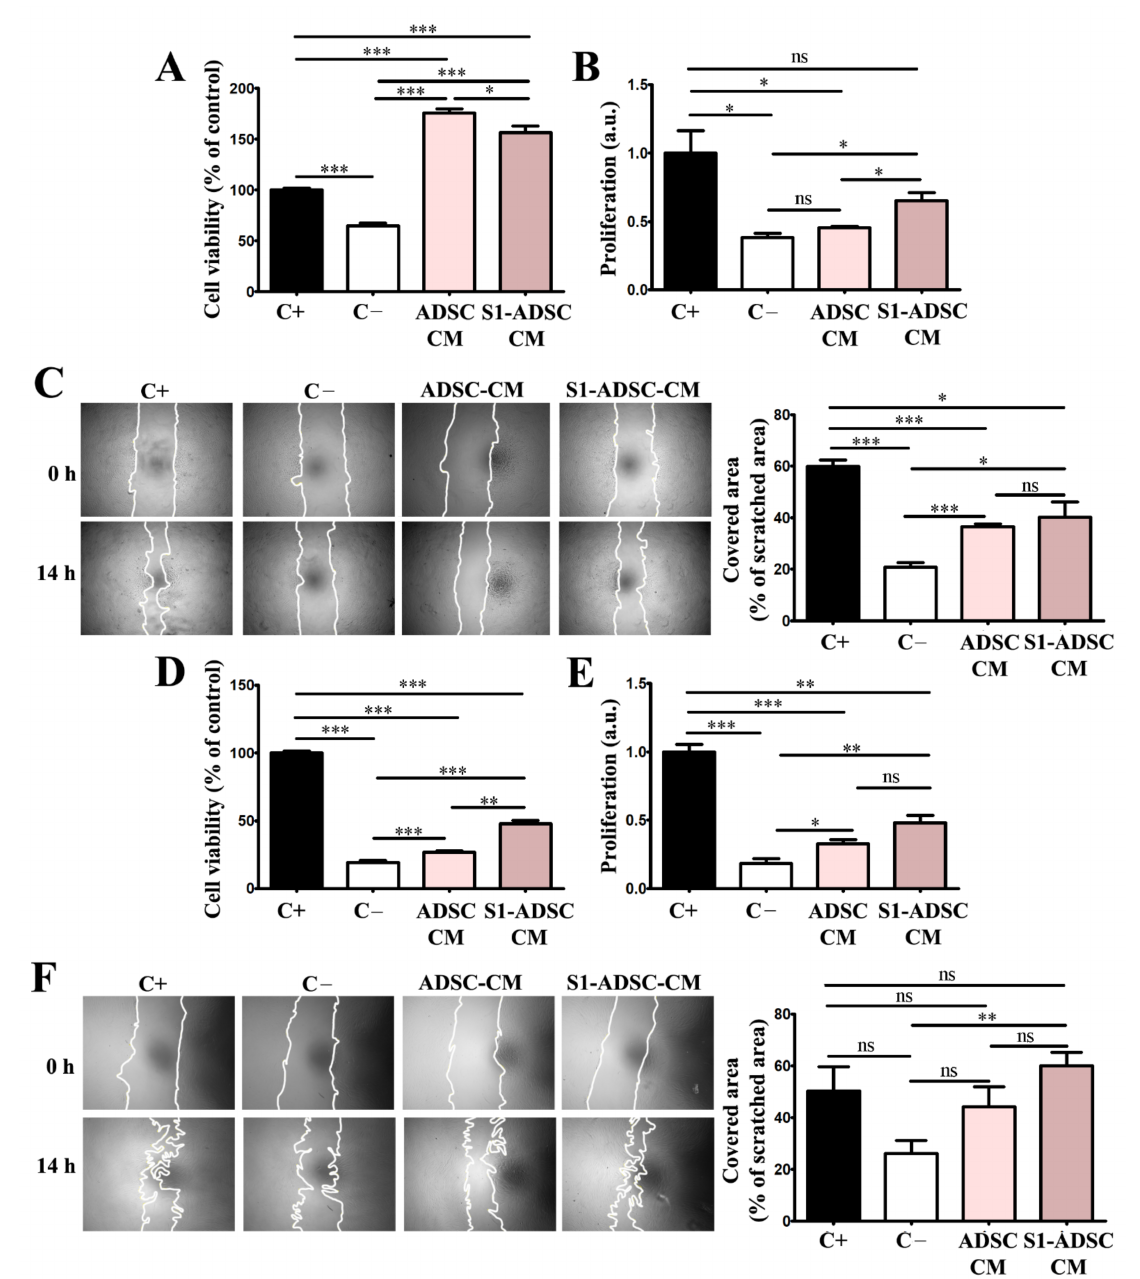
Figure 5. Assessment of the cell viability, proliferation and migration induced by hTERT S1-ADSC- CM on keratinocytes and hDF. ( A ) XTT assay showing the viability of keratinocytes cultured for 5 days in the presence of hTERT S1-ADSC-CM versus ADSC-CM; ( B ) Assessment of the capacity of hTERT S1-ADSC-CM versus ADSC-CM to promote keratinocyte proliferation as revealed by DNA quantification; ( C ) Keratinocyte migration assessed by Scratch test: (left) phase-contrast microscopy showing the scratched area at t = 0 h and 14 h later and (right) the quantification of covered area as a percentage of the initial scratched area. ( D ) XTT assay showing the viability of fibroblasts cultured for 5 days in the presence of hTERT S1-ADSC-CM versus ADSC-CM; ( E ) Assessment of the capacity of hTERT S1-ADSC-CM versus ADSC-CM to promote fibroblast proliferation as shown by DNA quantification; ( F ) Fibroblast migration assessed by Scratch test: (left) phase-contrast microscopy showing the scratched area at t = 0 h and 14 h later and (right) the quantification of covered area as a percentage of the initial scratched area. Data are means ± SD ( n = 3, *** p < 0.001; ** p < 0.01; * p < 0.05; ns p ≥ 0.05, not